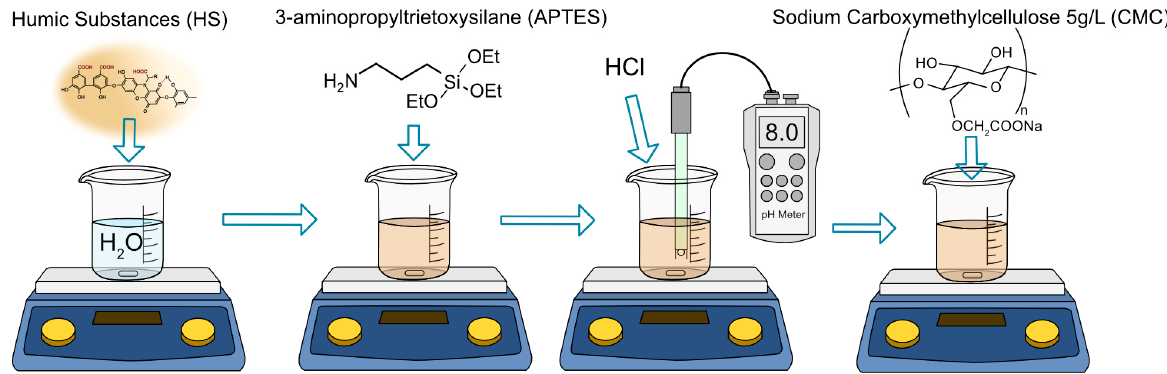
Figure 2. HS–ASQ preparation scheme.